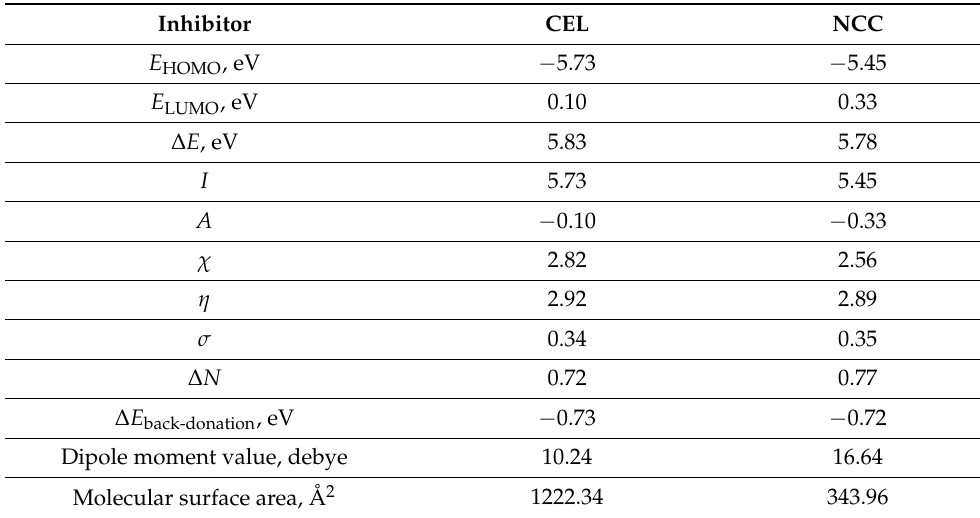
Table 4. The calculated quantum chemical parameters for the CEL and NCC . Inhibitor CEL